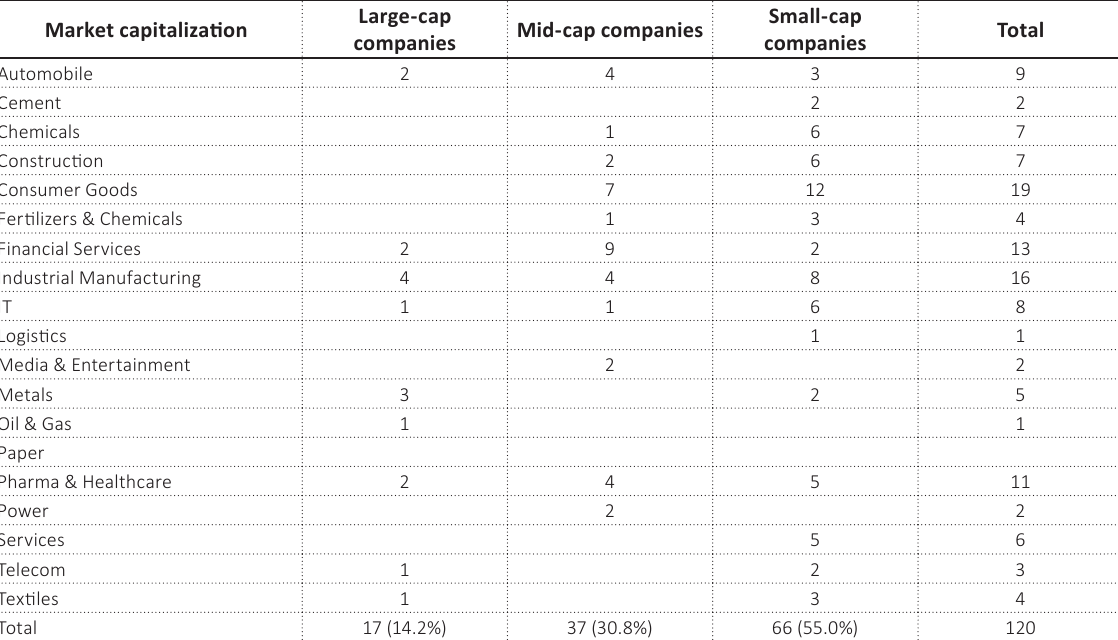
Table 4. Frequency table for 10-year excess returns > 3 ppt according to market capitalization and